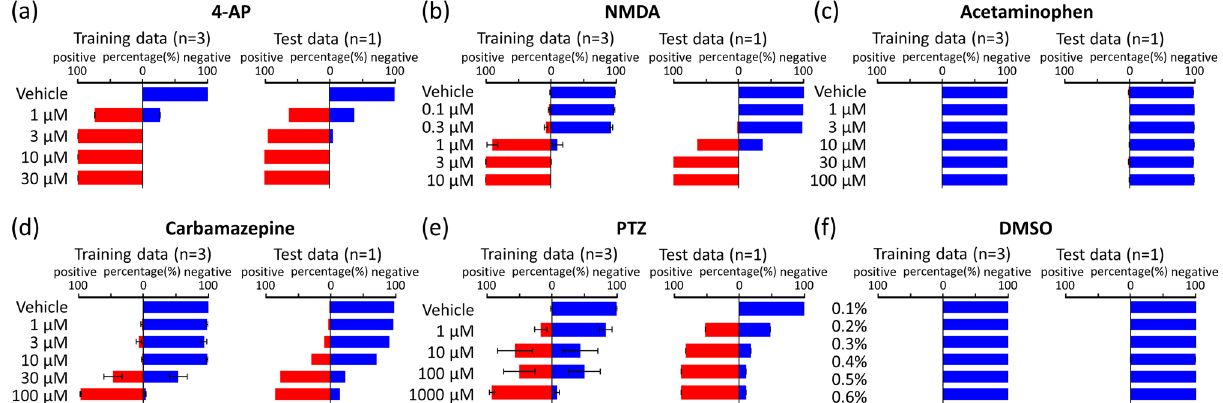
Figure 4. Concentration-dependent prediction of seizure risk in learning drugs by AI. AI predicted the negative probabilities (blue bar) and seizure risk (red bar) at each concentration of training data (left) and test data (right). (a) 4-AP, (b) NMDA, (c) acetaminophen, (d) carbamazepine, (e) PTZ, (f) DMSO.